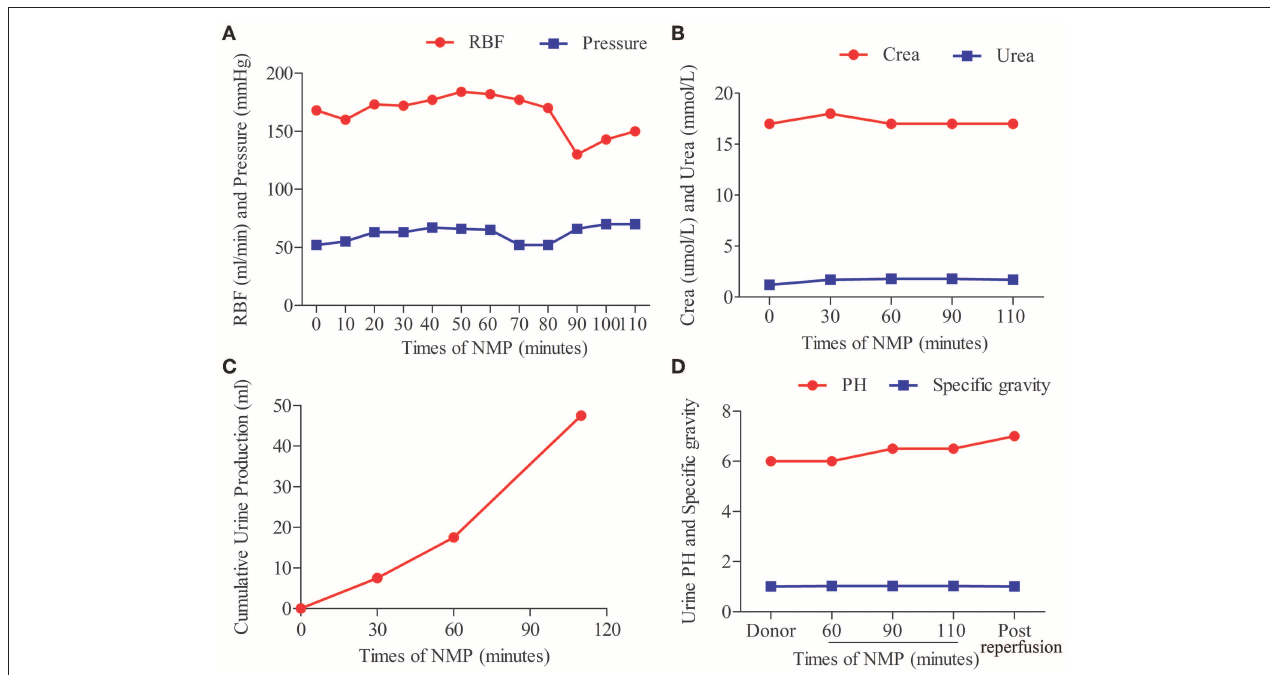
FIGURE 2 | Normothermic machine perfusion and allograft viability. (A) Arterial flow rates and pressure. (B) Creatinine (Crea) and urea concentration in the perfusate. (C) Volume of urine production during machine perfusion. (D) pH values and specific gravity levels of the urine produced before procurement, during machine perfusion, and post-reperfusion.